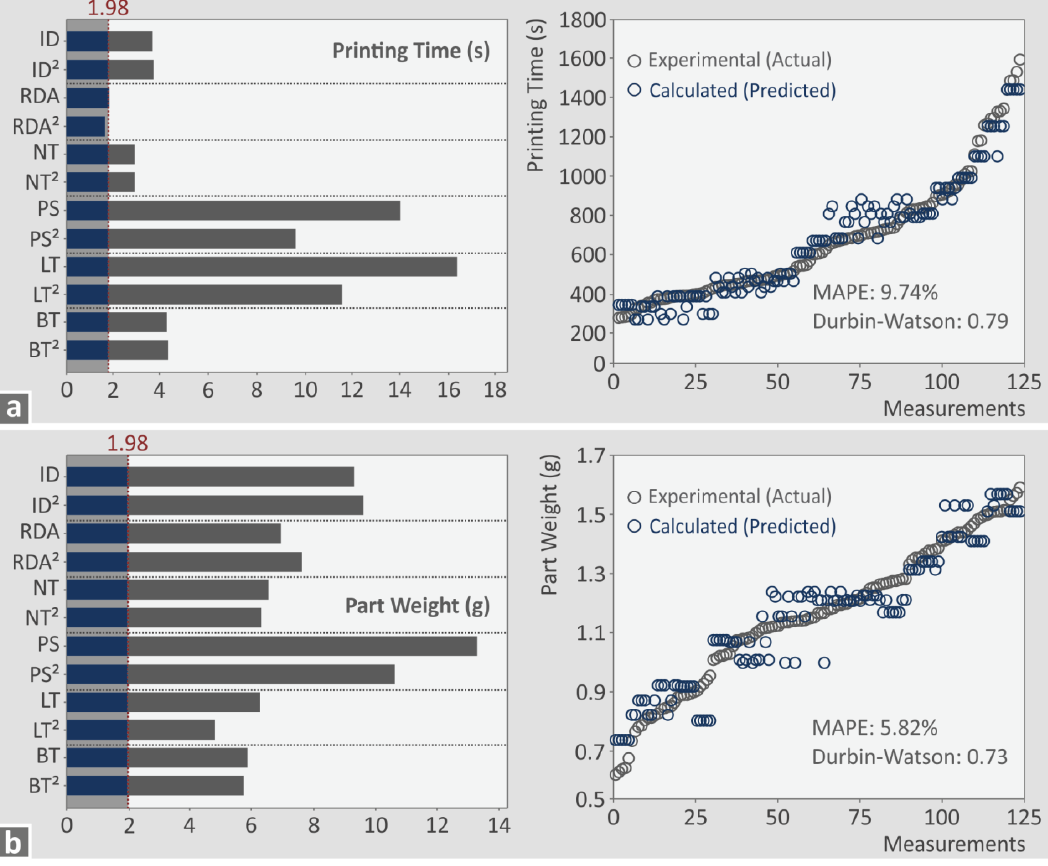
Figure 11. Pareto and experimental vs. calculated charts: ( a ) printing time (s), and ( b ) part weight (g).